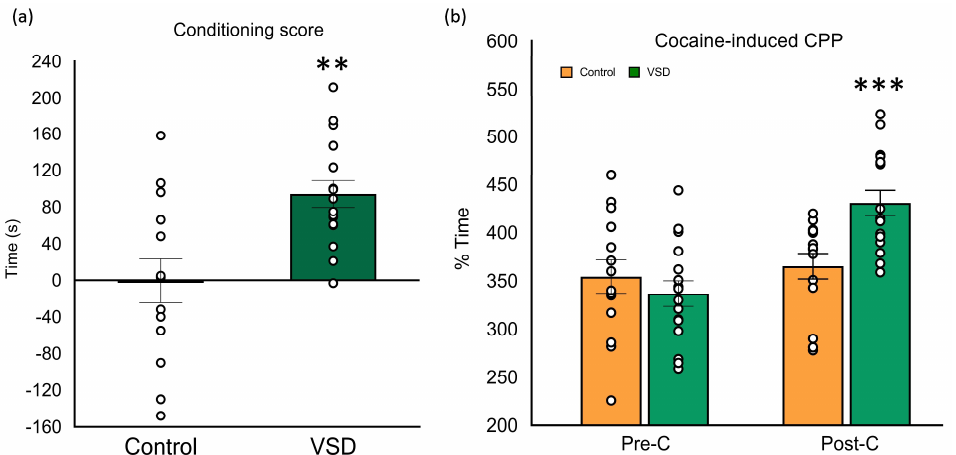
Figure 7. Vicarious Social Defeat (VSD) female mice showed preference in cocaine-induced Condi- tioned Place Preference (CPP). Female mice were divided into Control (n = 14) and VSD (n = 14). ( a )